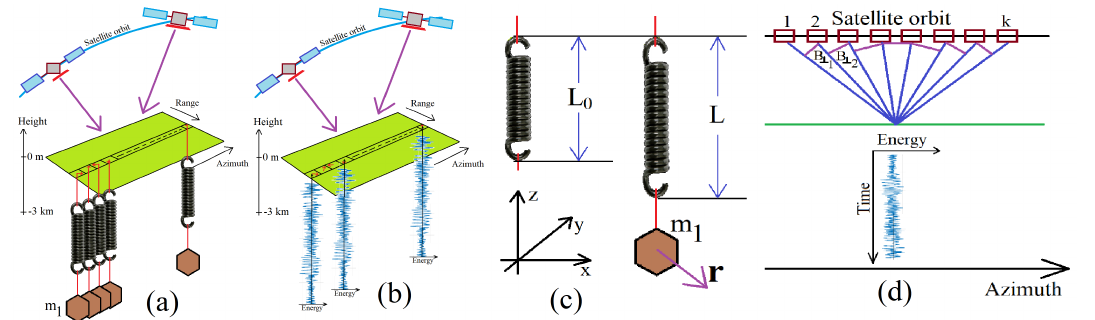
Figure 8. Tomographic acquisition geometry. ( a ): SAR acquisition of targets represented by harmonic mass oscillators. ( b ): SAR acquisition of targets represented by time-domain harmonic vibration functions. ( c ): Static representation in a 3D spatial reference system of a spring when expanded by a mass. The spring from a length L 0 is dilated by gravity acting on the mass m 1 , to a length L . ( d ): Details of the tomographic acquisition geometry along the satellite orbit. All orthogonal baselines are